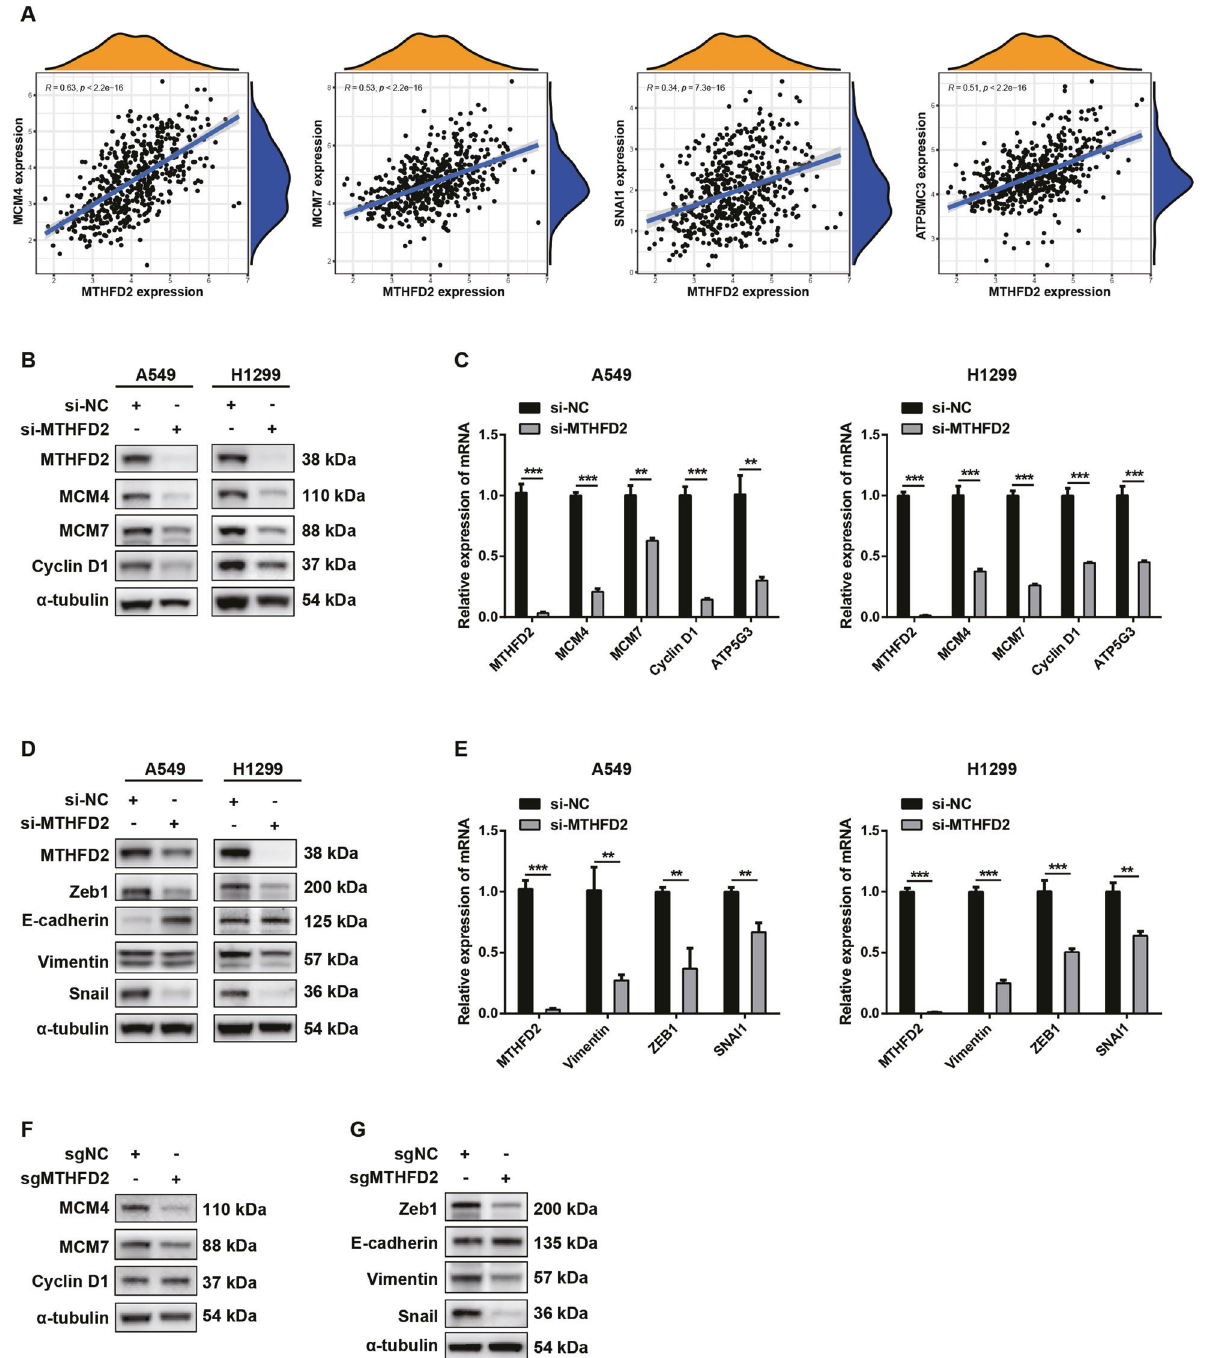
Fig. 4 Downstream molecular targets in MTHFD2-knockdown LUAD cell lines. A TCGA database showed the positive correlation between MTHFD2 and MCM4 , MCM7 , SNAI1 and ATP5MC3 . B The protein levels of MTHFD2, MCM4, MCM7, Cyclin D1 in MTHFD2-knockdown A549 (left panels) and H1299 (right panels) cells. α -tubulin was used as an internal control. C The mRNA levels of MTHFD2 , MCM4 , MCM7 , Cyclin D1 and ATP5G3 normalized to β -actin in MTHFD2-knockdown A549 (left histogram) and H1299 (right histogram) cells. D The protein levels of MTHFD2, Zeb1, E-cadherin, Vimentin and Snail in MTHFD2-knockdown A549 (left panels) and H1299 (right panels) cells. α -tubulin was used as an internal control. E The mRNA levels of MTHFD2 , Vimentin, ZEB1 and SNAI1 normalized to β -actin in MTHFD2-knockdown A549 (left histogram) and H1299 (right histogram) cells. F , G The protein levels of cell growth regulators (MCM4, MCM7, Cyclin D1) and EMT markers (Zeb1, E- cadherin, Vimentin, Snail) in MTHFD2-knockout A549 cells. α -tubulin was used as an internal control. ** P < 0.01, *** P < 0.001. of MTHFD2 using by analyzing TCGA LUAD database. Transient downstream targets of MTHFD2. Indeed, DNA helicases such as silencing of MTHFD2 in fl uences primary cellular events such as minichromosome maintenance protein family members, MCM4 proliferation, apoptosis and migration by inhibiting several and MCM7, which function as essential for eukaryotic chromo- downstream molecules, including MCM4, MCM7, Cyclin D1, and some replication, are positively correlated with the expression Cell Death Discovery (2022)